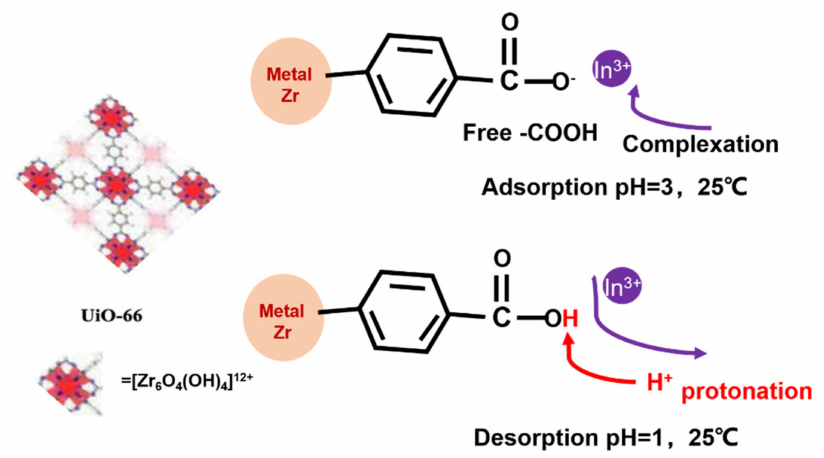
Figure 8. Schematic illustration of adsorption and desorption of In(III) by